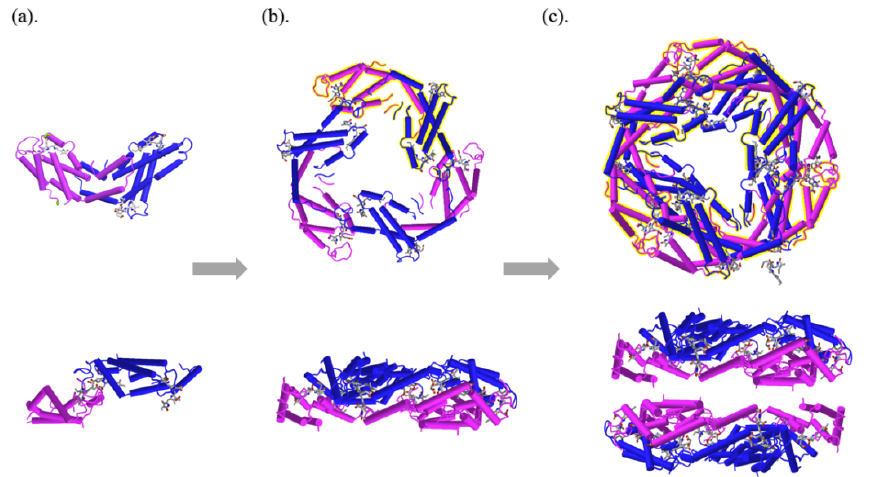
Figure 2. Cylinder and plate representation of PC monomer ( a ), PC trimer ( b ), and PC hexamer ( c ).